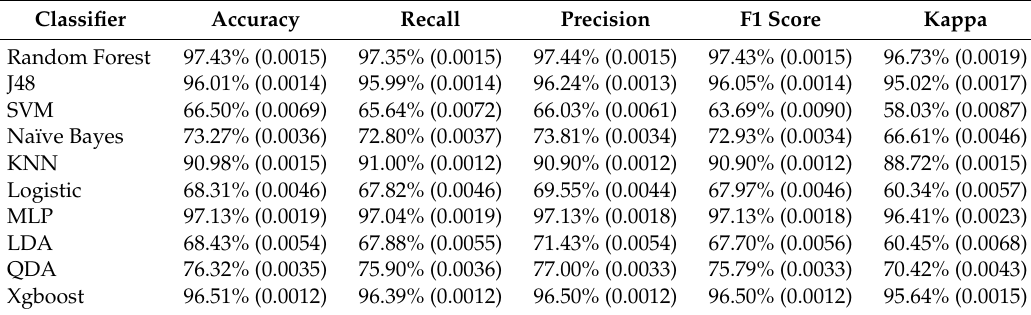
Table 10. ML-based classifier performance on Day-2 dataset.